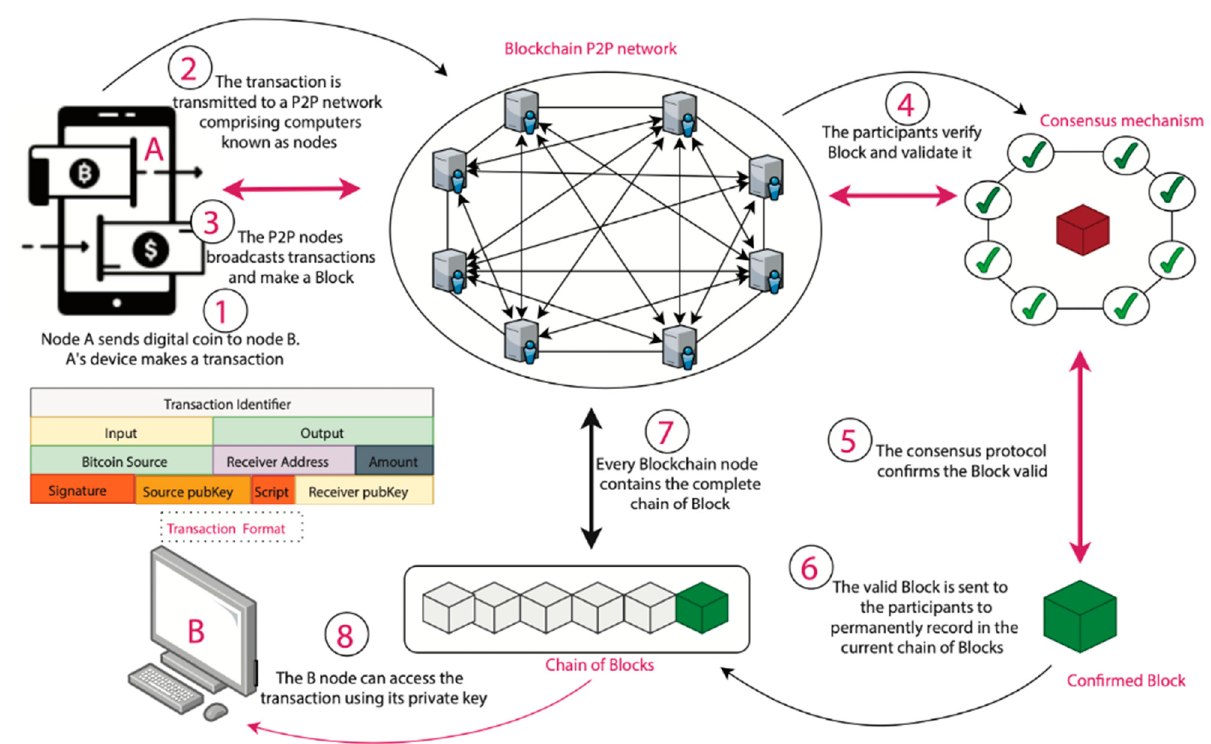
Figure 1. Processing of blockchain [3].